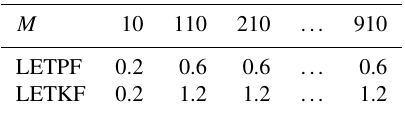
Table 1. Optimal localization radius for LETPF and LETKF at dif- ferent ensemble sizes M